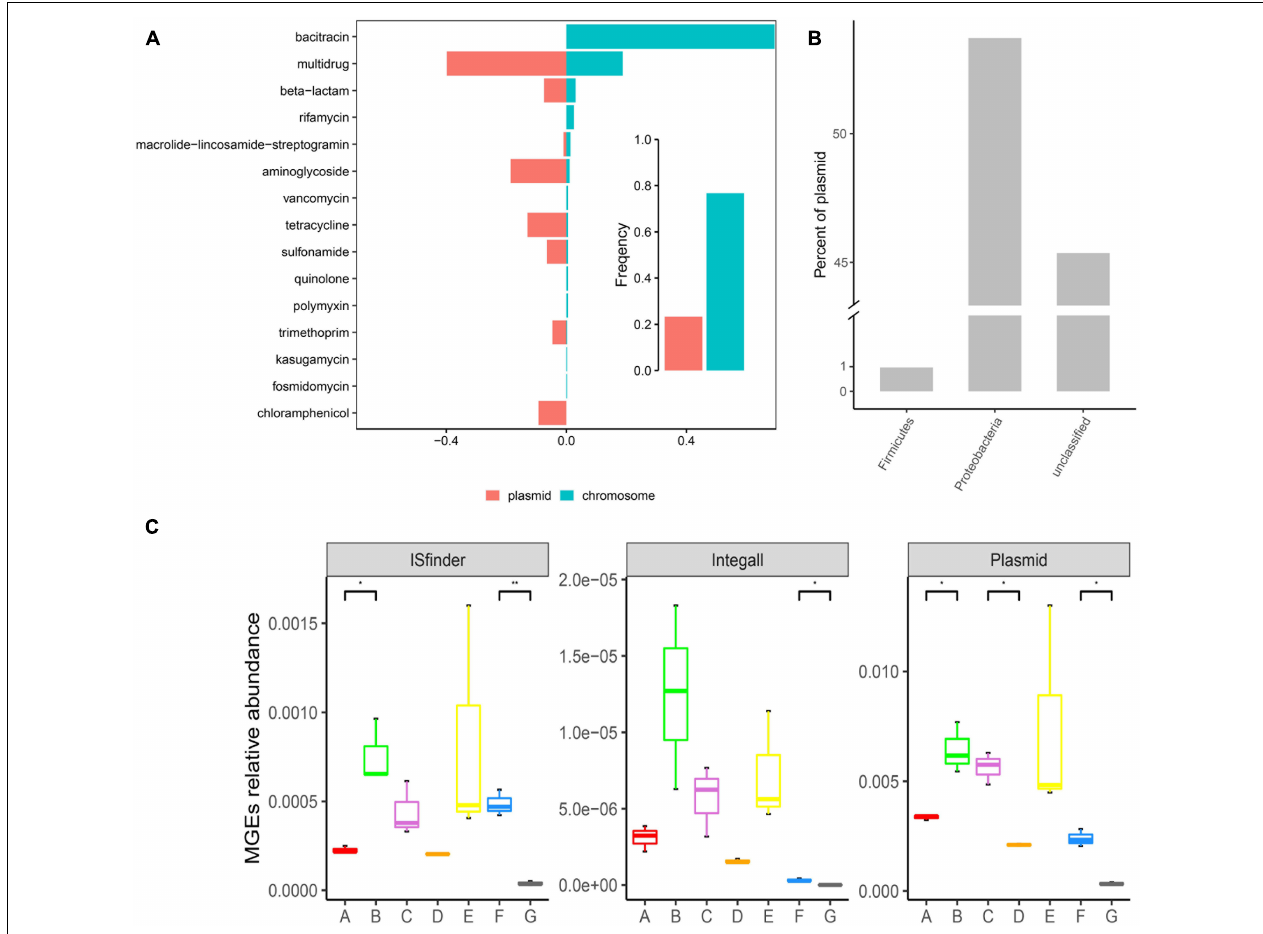
FIGURE 5 | Distribution of ARGs in mobile genetic elements (MGEs) and distribution of MGEs in the DWTS. (A) Occurrence and abundance of ARG types in MGEs. Bar plot showing the frequency of ARGs in bacterial chromosomes (blue) or plasmids (red) summarized by antibiotic class. (B) Distribution of plasmids in bacteria (at the phylum level). (C) Distribution of MGEs in the DWTS. A: raw water; B: grid reaction tank effluent; C: settling pond effluent; D: quartz sand; E: sand filter effluent; F: chlorine-disinfected water; G: tap